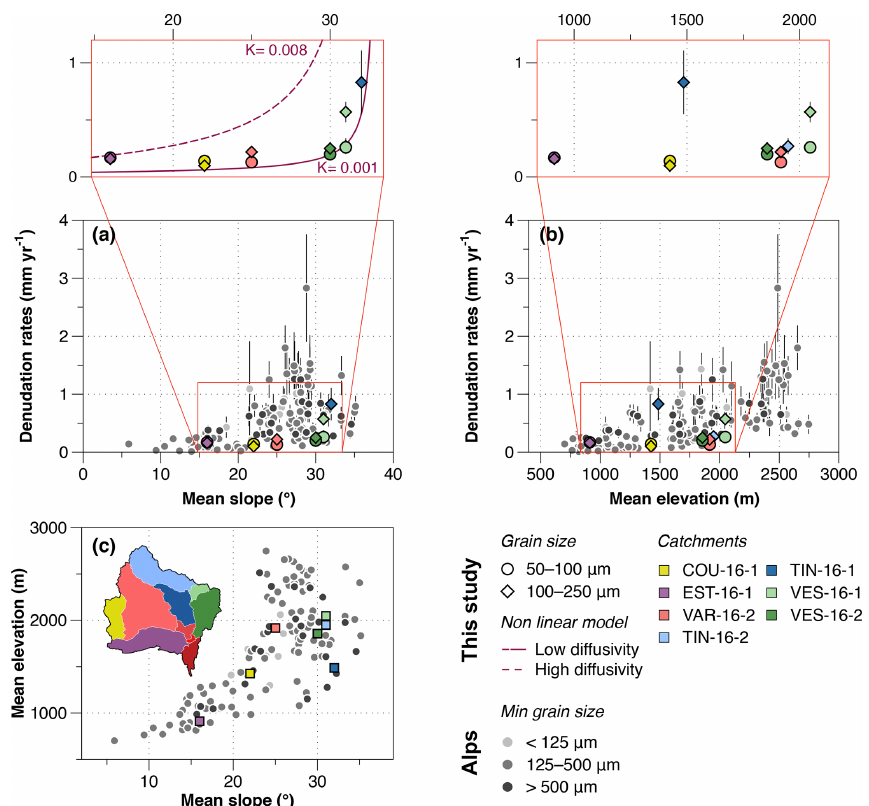
Figure 4. 10 Be-derived denudation rates in the Var basin and elsewhere in the Alps plotted against (a) mean basin slope and (b) mean basin elevation. The relationship between mean elevation and slope is plotted in (c) . For the Var basin, all parameters were calculated for quartz-bearing surfaces only using a 5m resolution DEM from the Institut National de l’Information Géographique et Forestière (http: //professionnels.ign.fr/donnees, last access: 6 December 2019). For the COU-16-1, EST-16-1, TIN-16-2, and VES-16-1 subbasins, we used denudation rates from Table 1. For the VAR-16-2, TIN-16-1, and VES-16-2 subbasins, we used subbasin 10 Be denudation rates (Table 2). We used the OCTOPUS database (Codilean et al., 2018) to acquire data from the Alps (Buechi et al., 2014; Chittenden et al., 2014; Delunel et al., 2010; Dixon et al., 2016; Glotzbach et al., 2013; Grischott et al., 2017a; Molliex et al., 2016; Norton et al., 2008, 2011; Savi et al., 2014; Wittmann et al., 2007,